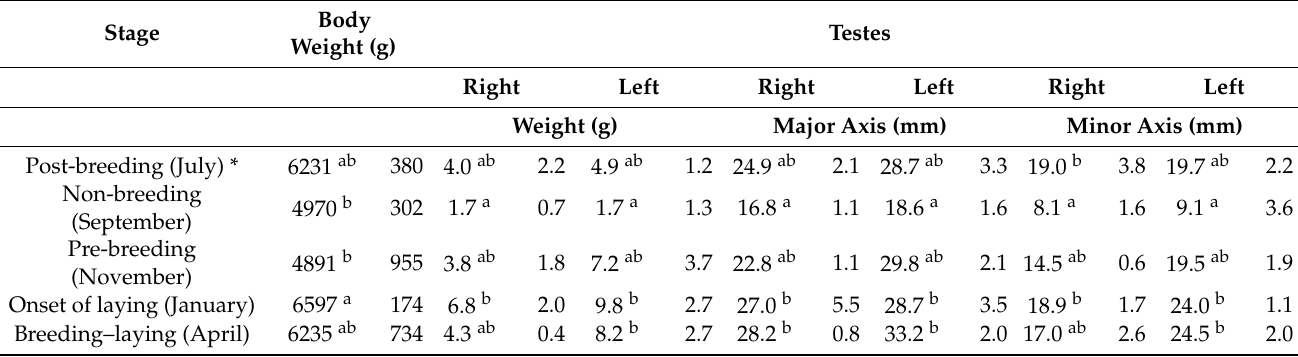
Table 1. Body weight and testes characteristics (median, interquartile range) in 2-year-old Zatorska ganders ( n = 5/stage) during the different stages of the annual